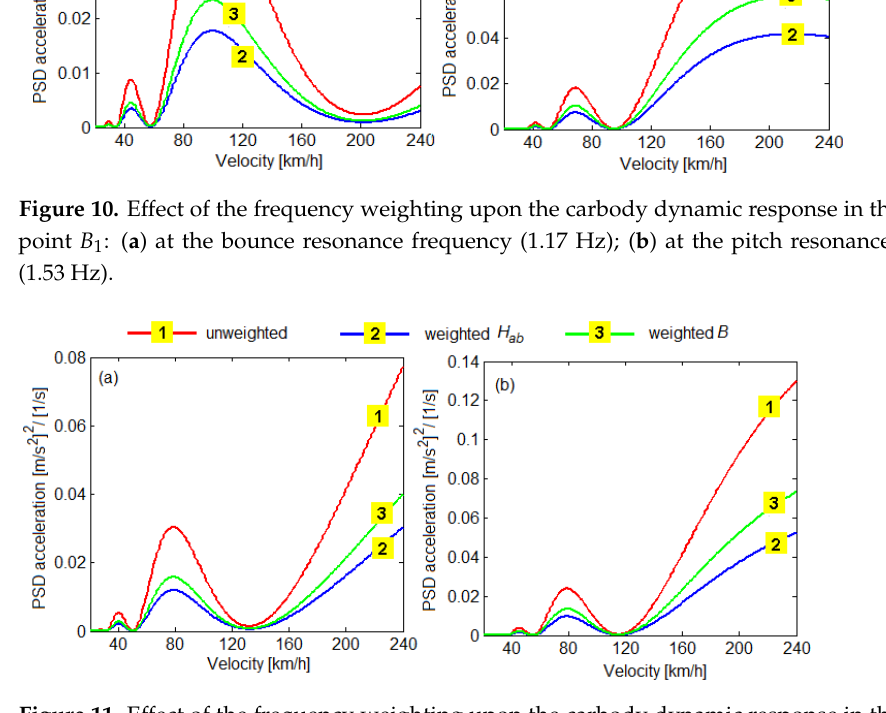
Figure 11. Effect of the frequency weighting upon the carbody dynamic response in the reference point B 2 : ( a ) at the bounce resonance frequency (1.17 Hz); ( b ) at the pitch resonance frequency (1.53 Hz).